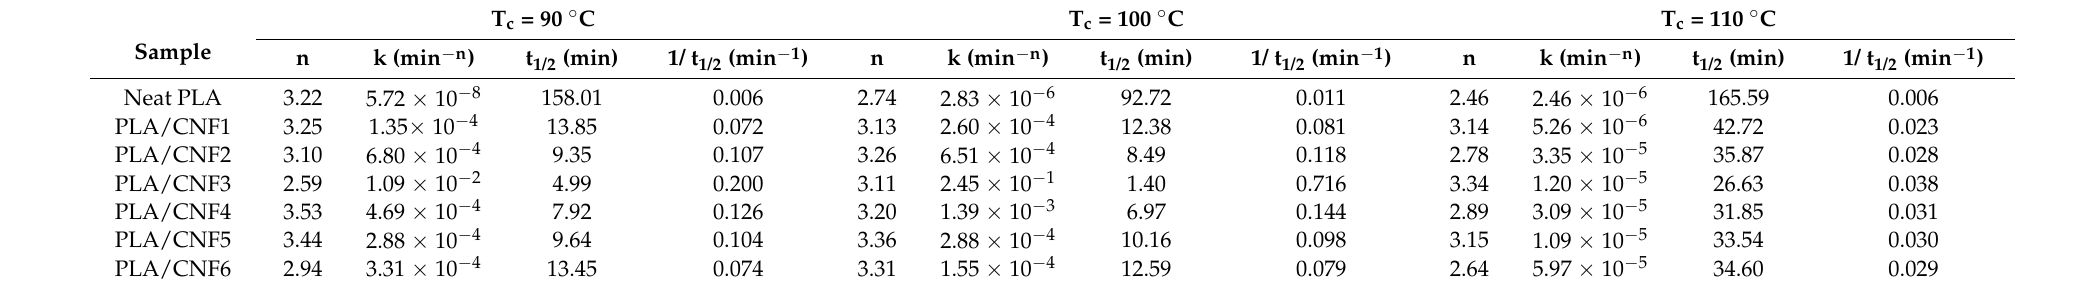
Table 2. Avrami parameters for isothermal crystallization of PLA/CNF